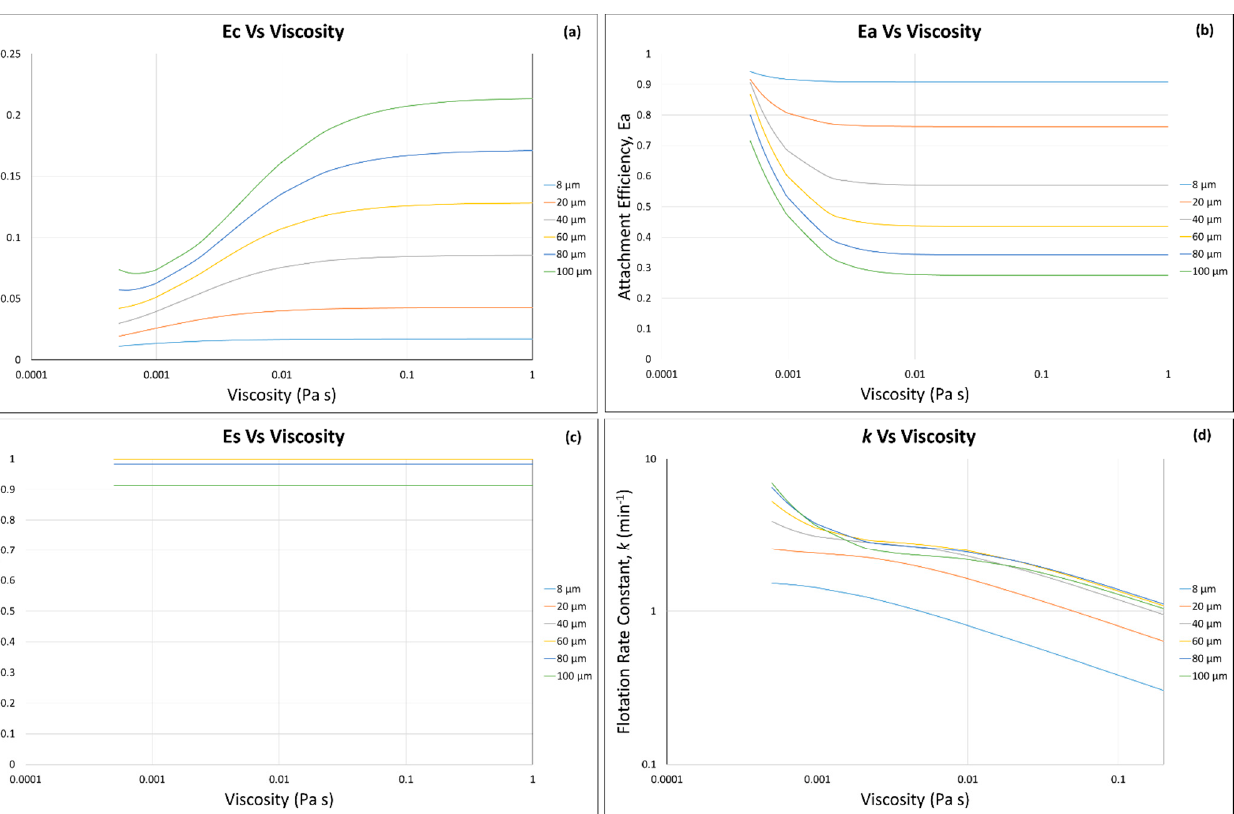
Figure 3. Effect of quartz particle suspension viscosity on calculated ( a ) E c , ( b ) E a , ( c ) E s , and ( d ) k , as a function of particle diameter, at ε = 10 m 2 s − 3